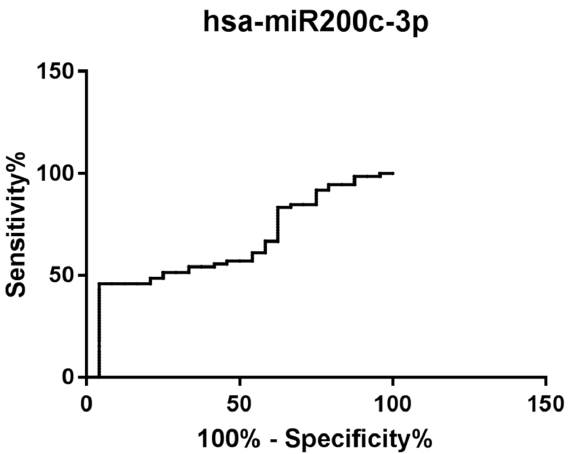
Figure 6. Receiver operator characteristic (ROC) analysis of hsa-miR-200c-3p expression levels. Area under the ROC curve (AUC) = 0.65, 95% confidence interval: 0.53 to 0.77, p -value < 0.05.